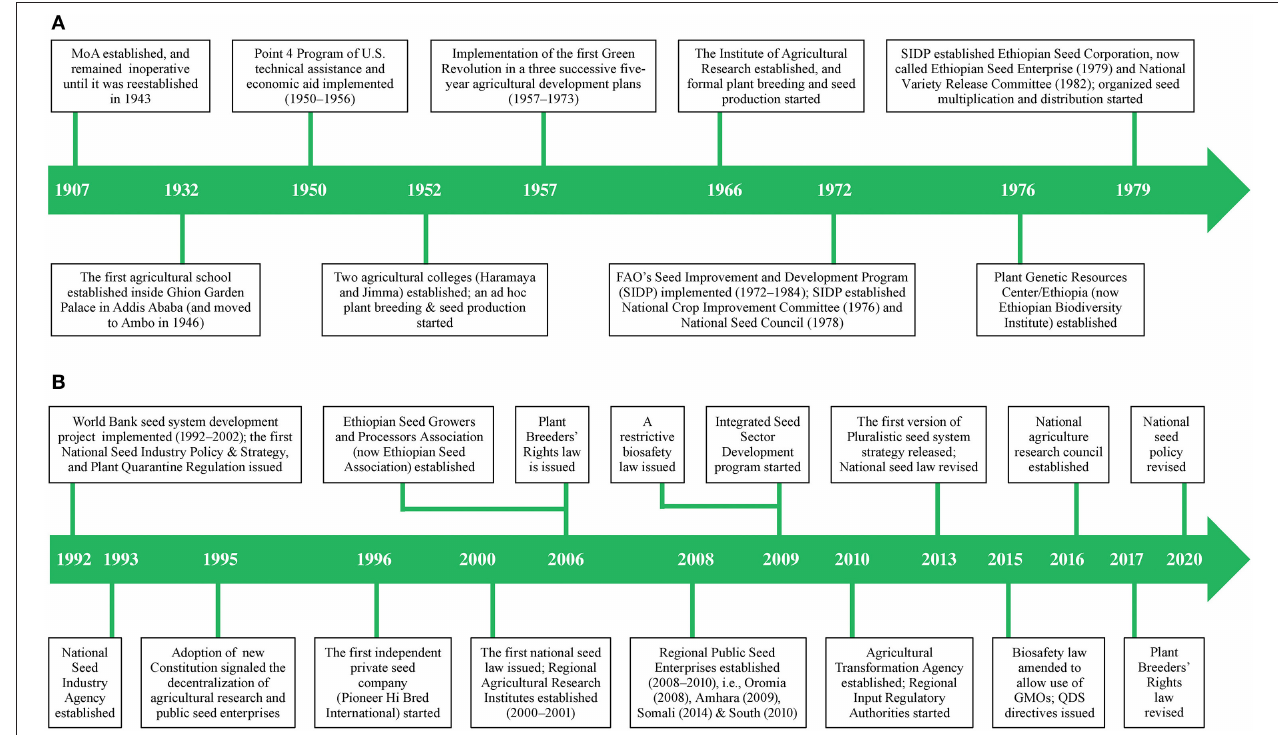
FIGURE 1 | Timeline of major historical landmarks of the Ethiopian seed system policy and institutional developments during (A) the imperial (1889–1974) and socialist (1974–1991) governments, and (B) the developmental state government regime after 1991.